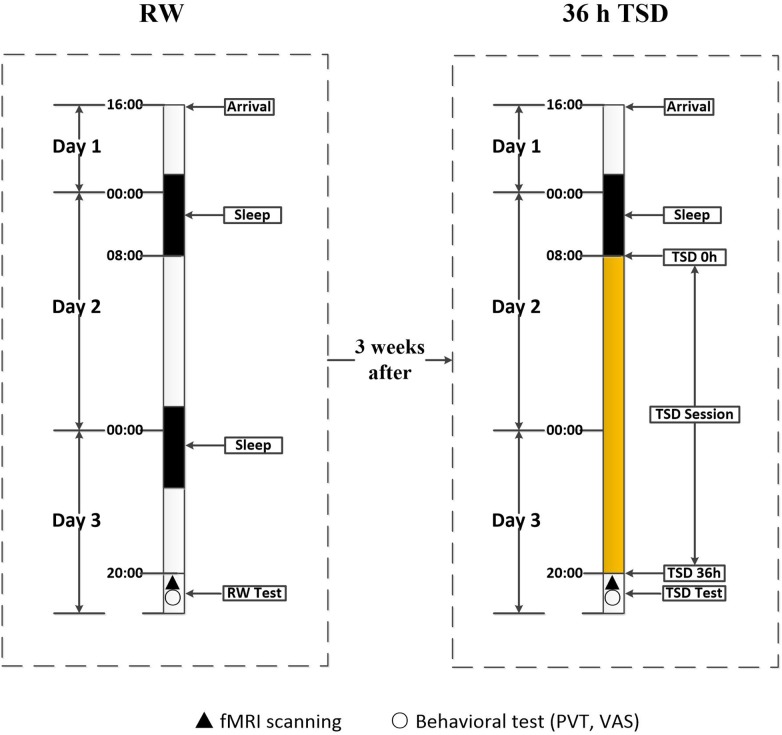
Experimental design and protocol. The experiment consisted of an RW and a TSD component, which were separated by an interval of 3 weeks. During each component, participants entered the laboratory at 4:00 PM on the first day, and underwent functional magnetic resonance imaging and behavioral testing at approximately 8:00 PM on the third day. In the RW component, participants went through two routine nocturnal sleep periods. In the TSD component, participants underwent 36 h of TSD after one routine nocturnal sleep period. The 36 h of TSD started at 8:00 AM on the second day and ended at 8:00 PM on the third day. TSD, total sleep deprivation; RW, rested wakefulness.